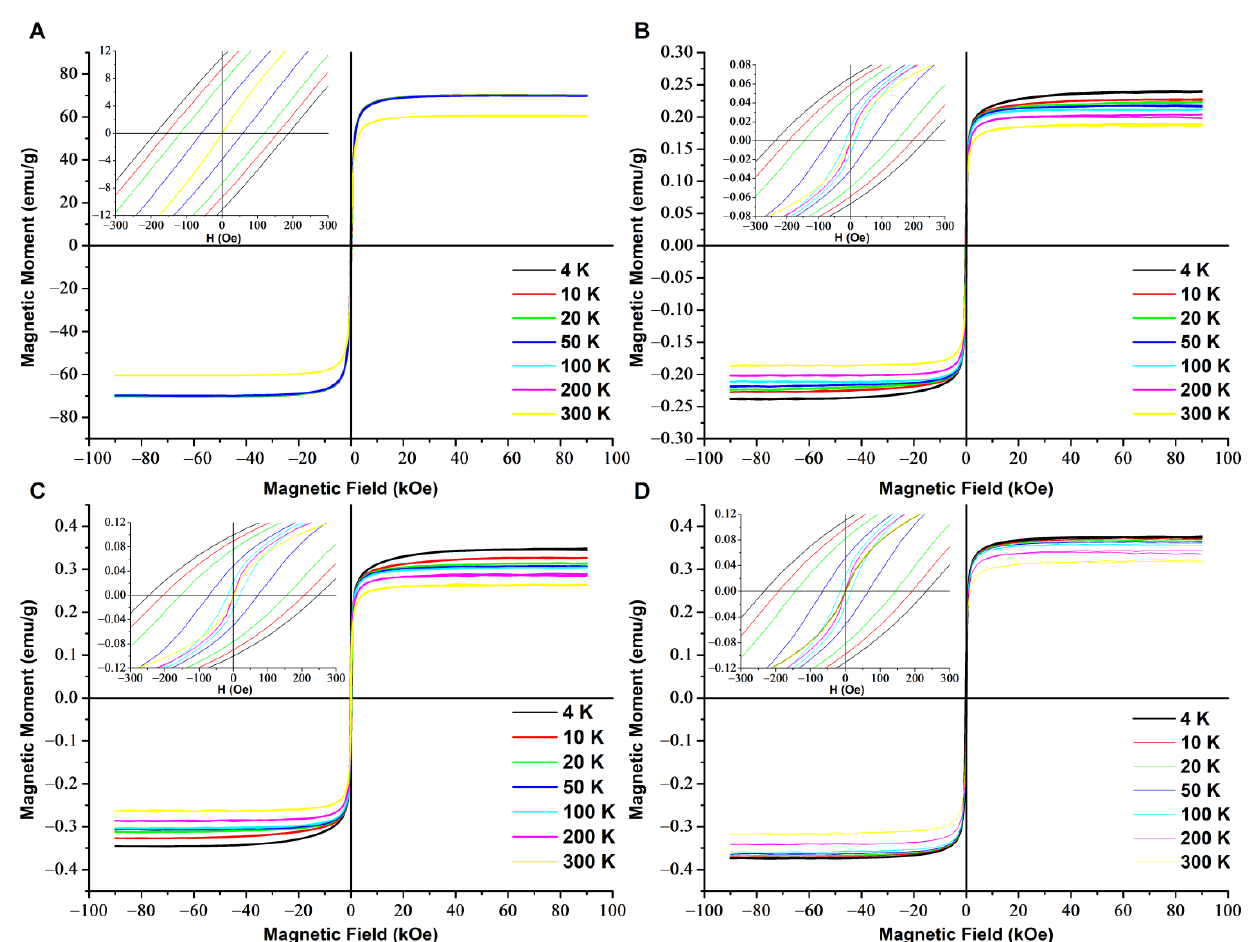
Figure 1. Magnetization curves measured for SPIONs ( A ) and hybrids: ColCh 0:100 S1 ( B ), 25:75 S1 ( C ), and 50:50 S1 ( D ) . The insets show an enlarged region at the origin.